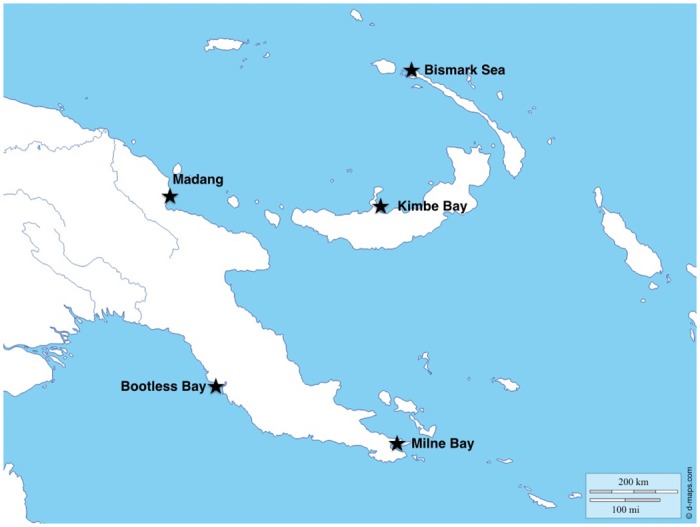
Location of sampling areas.Map downloaded and used with permission from http://www.d-maps.com.